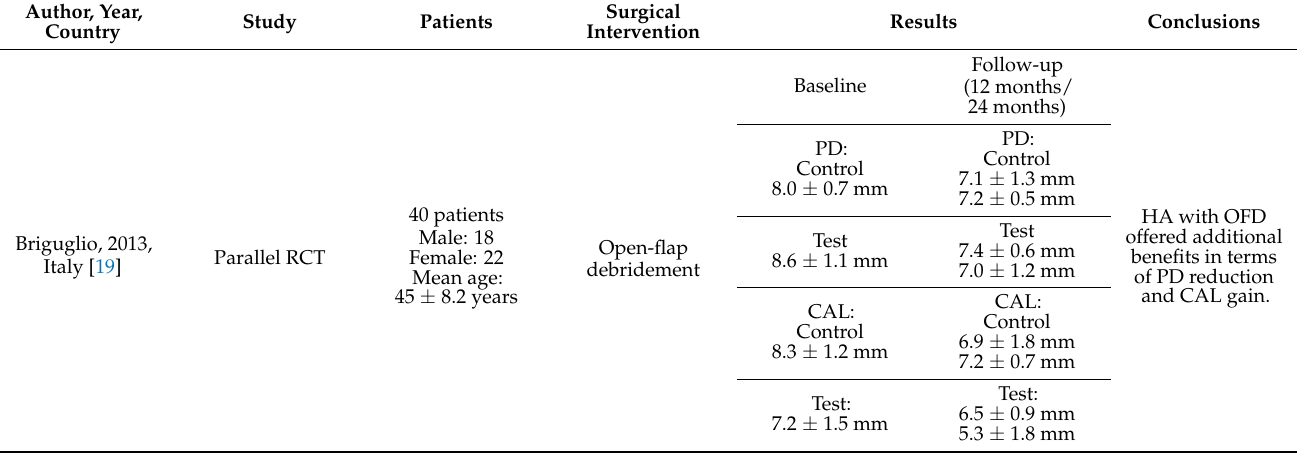
Table 2. Characteristics of the studies included.